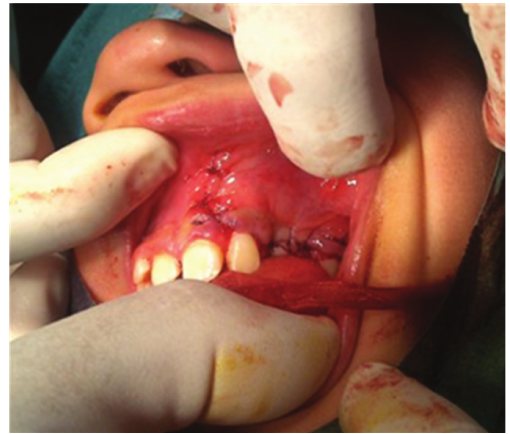
Figure 10: Primary closure done.